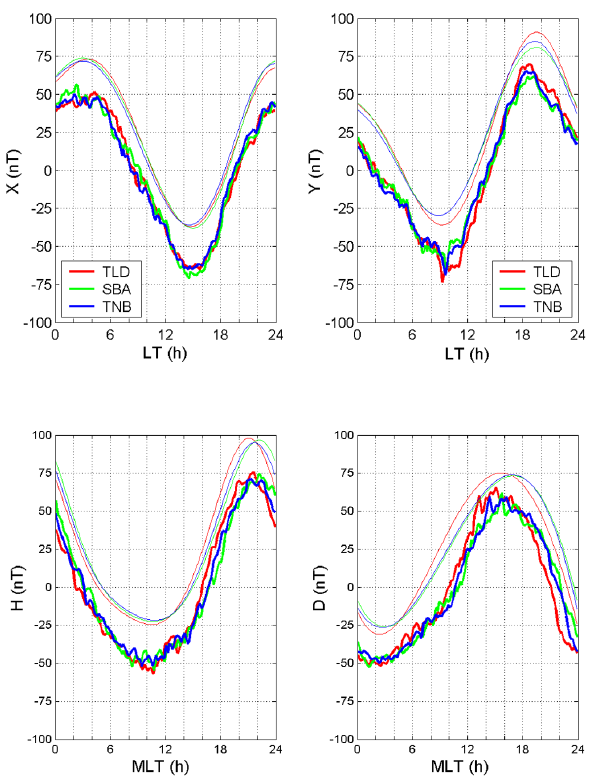
Figure 4. Daily distribution of the average 10min values of the two horizontal geomagnetic field component variation in the ge- ographic reference system vs. LT (upper panels, thick lines) and in the geomagnetic reference system vs. MLT (lower panels, thick lines). Each point represents the variation at a fixed 10min interval, averaged over the whole analyzed time period. In all panels thin lines represent the fits of the experimental curves, upward shifted of 25nT. Figure 5. Daily magnetograms of the horizontal components H and